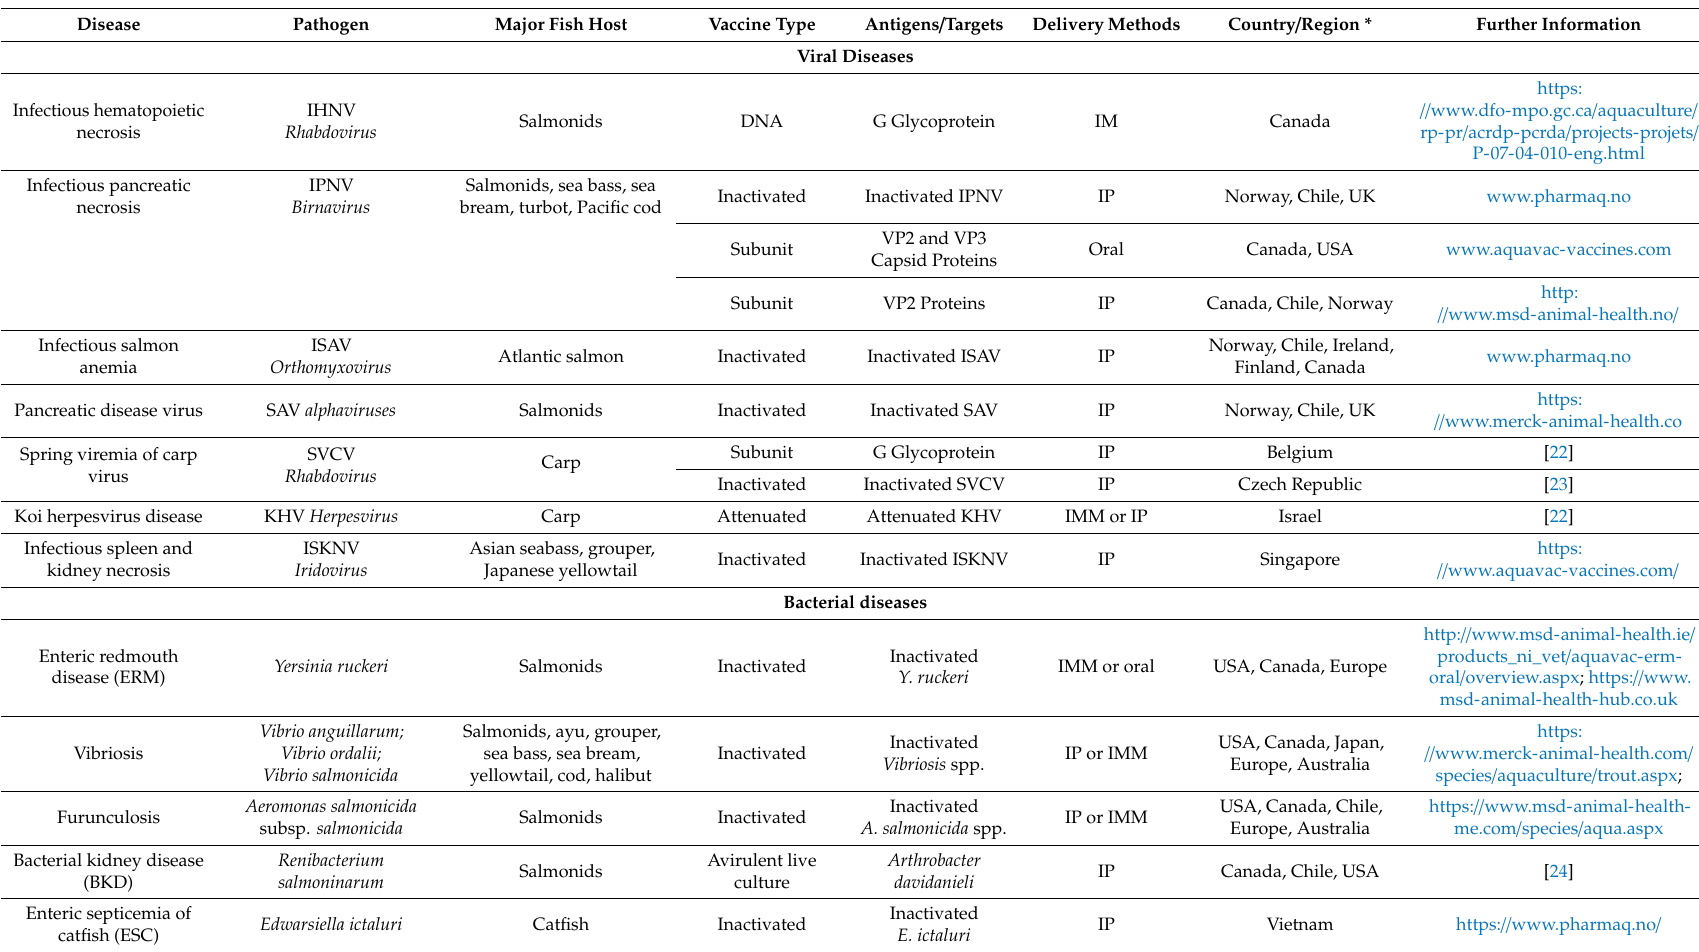
Table 1. Overview of licensed fish vaccines that have been used in global